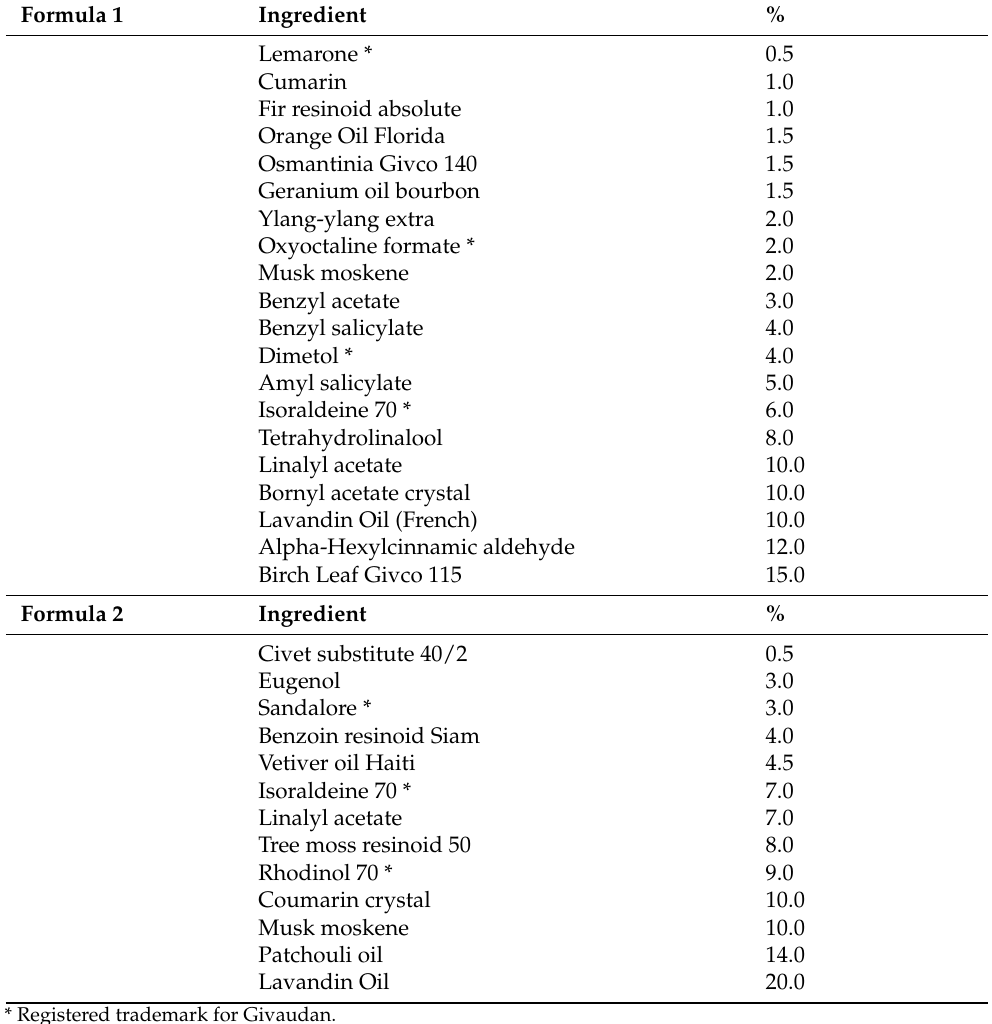
Table 4. Examples of Foug é re type fragrance compositions